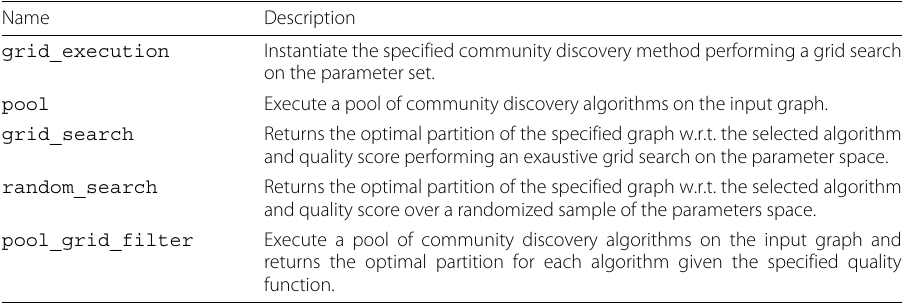
Table 1 Ensemble functionalities offered by CD LIB Name